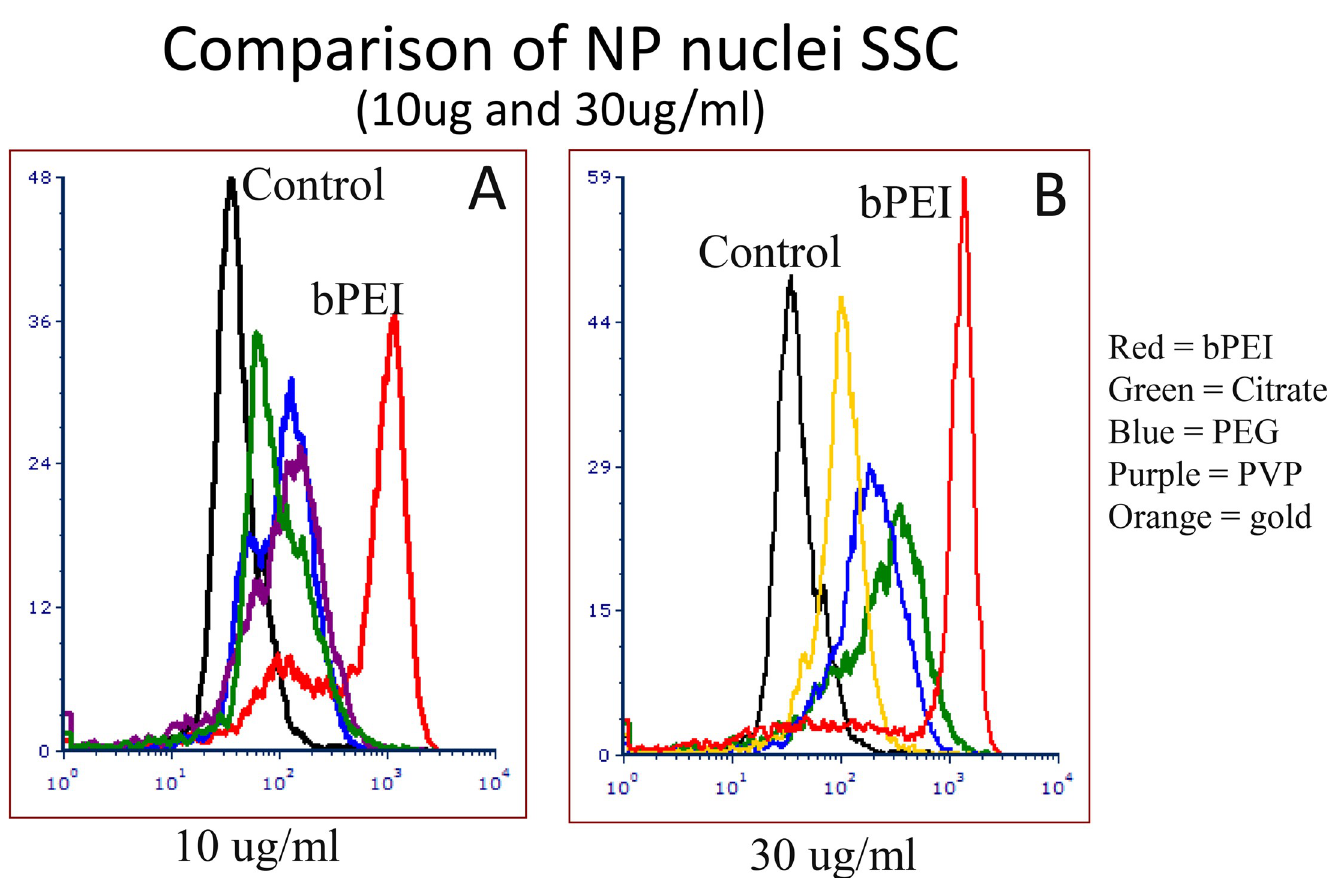
Fig 6. Comparison of nuclei SSC histograms from NP treated cells. Histograms of nuclei derived from cells treated with the 4 types of AgNP at 10 μ g/ml (Fig 6A) and 30 μ g/ml (Fig 6B). All samples demonstrated an increase of scatter after AgNP incubation for 24 hours at doses between 1 and 30 μ g/ml. All the AgNP showed greater SSC than the AuNP.